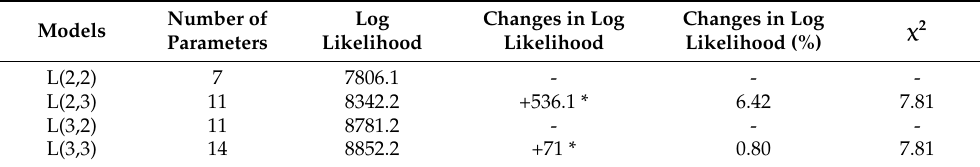
Table 2. Maximum log-likelihood values and changes in the log likelihoods at the different models.